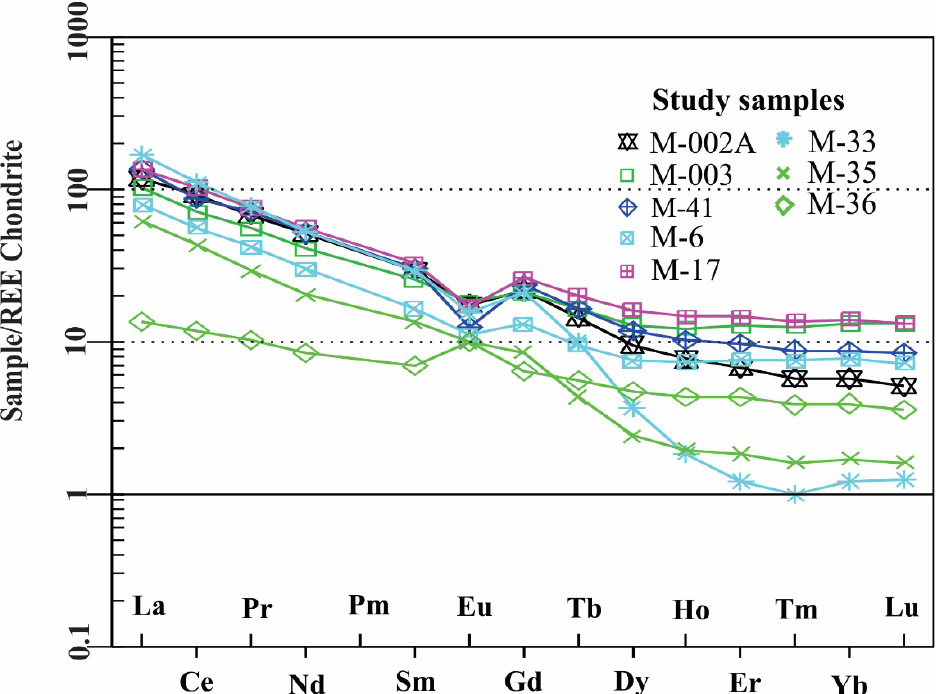
Figure 10. Chondrite-normalized plot of rare-earth element concentrations for rock samples after [99], collected from northern Myanmar. See Table 2 for complete geochemical results.